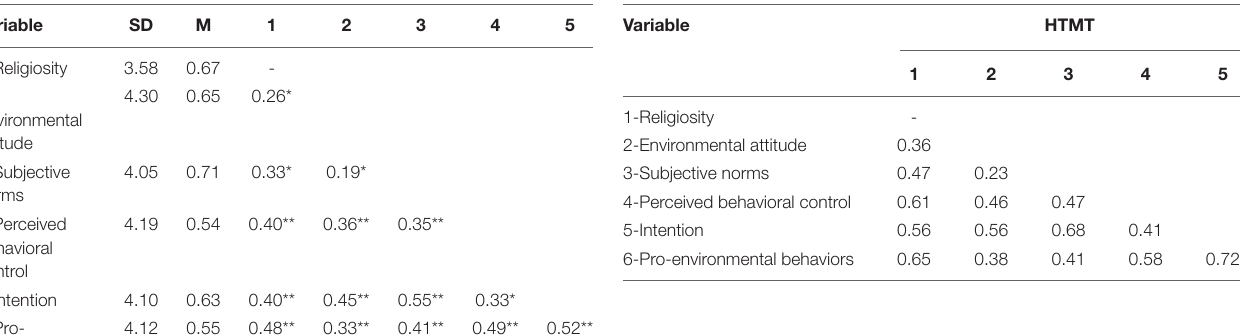
TABLE 4 | Discriminant validity